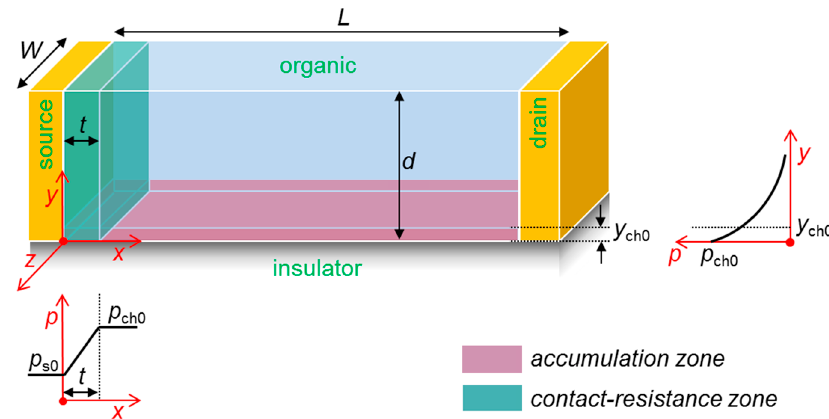
Figure 1. The conceptual representation of the 3-D organic channel in an organic field-effect transistor (OFET) that we employed for developing a contact resistance ( R c ) model (not to scale). A bottom-gate configuration is assumed, and the gate electrode is not shown for simplicity. All physical parameters are defined in the main text.